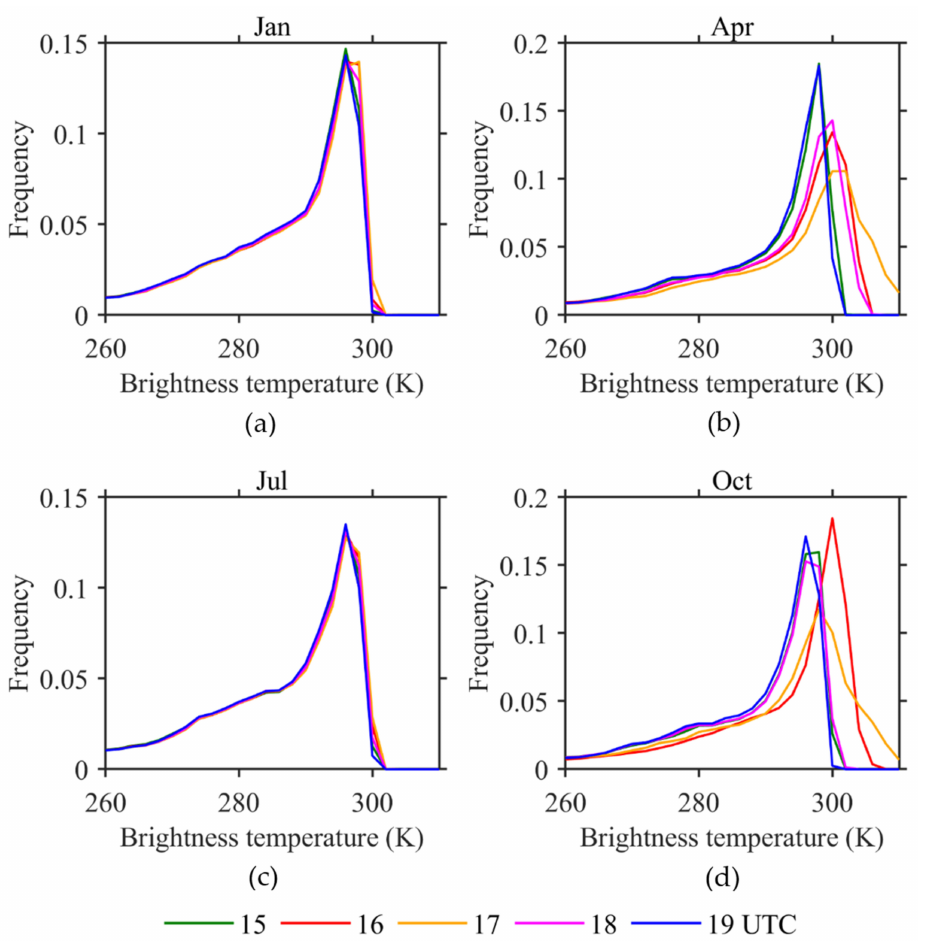
Figure 3. Frequency distribution of AGRI band–8 brightness temperatures within 2 K–intervals for all valid observations with satellite zenith angles less than 60 ◦ and over the ocean during 1500, 1600, 1700, 1800, and 1900 UTC in ( a ) January, ( b ) April, ( c ) July, and ( d ) October 2019. Note that no pixels with solar zenith angles less than 90 ◦ were observed at these